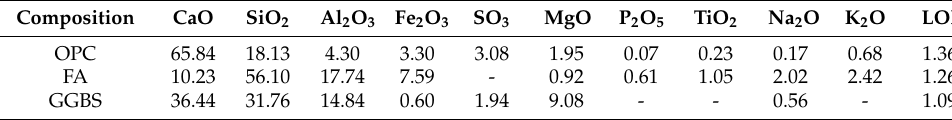
Table 1. Chemical compositions of the raw materials